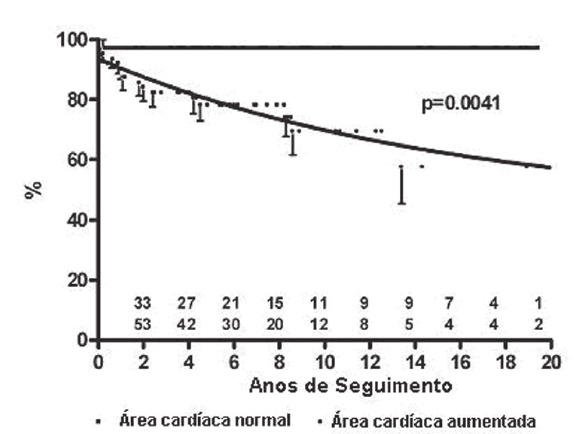
Fig. 3 - Influência do tamanho da área cardíaca no pré-operatório na probabilidade de sobrevida de crianças submetidas a estimulação cardíaca permanente pela via endocárdica transfemoral. Círculos = área cardíaca moderada/muito aumentada; quadrados = área cardíaca normal / discretamente aumentada